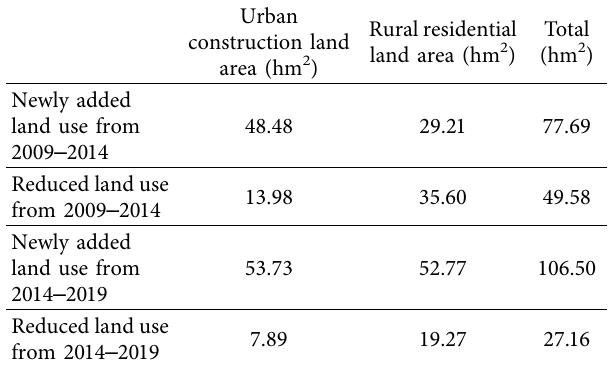
Table 4: Changes in construction land of Ciyutuo Subdistrict from 2009 ‒